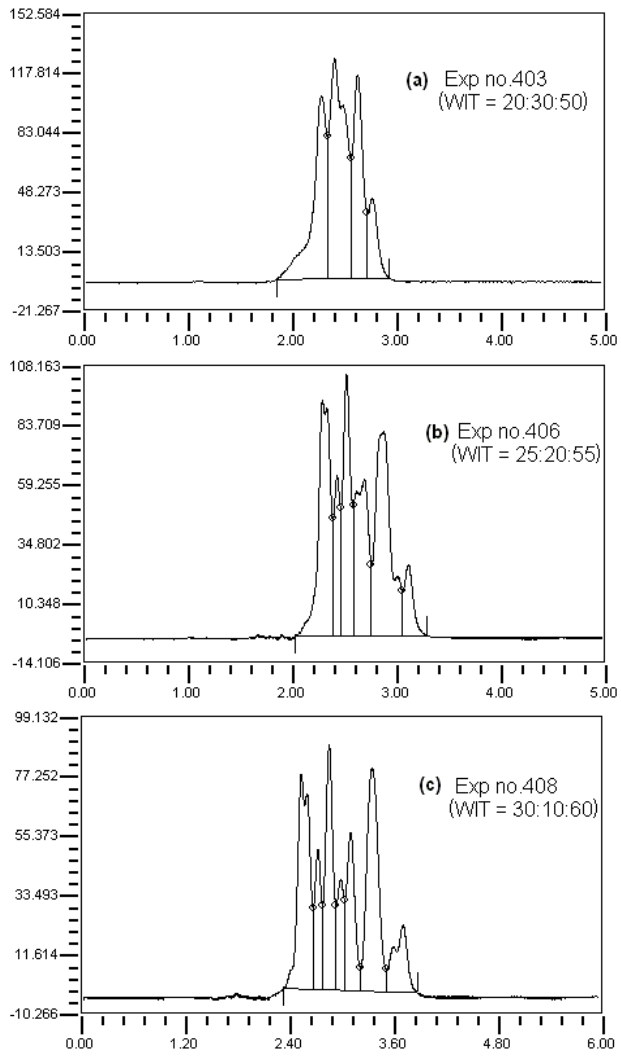
FIGURE 3. Chromatogram of a mixture of 15 DNPH(o) derivatives (48 ng of CCs) in WIT ternary mobile phase with detection at 360